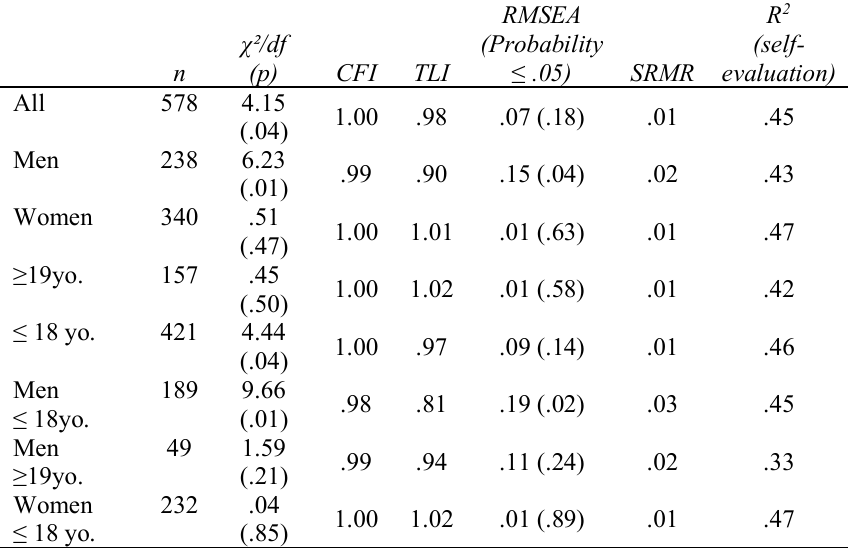
The fit indexes for a model of the regulation of